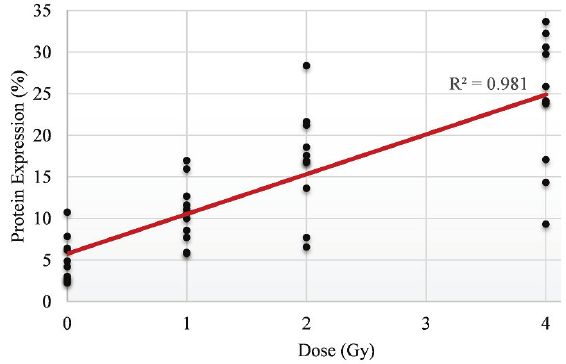
Figure 3 - Dispersion of active caspase-3 expression for lymphocytes incubated for 24 h. Black dots symbolize individual data for each radiation dose (n = 10), and red dots, mean values. The red line represents the linear trendline, displayed with coefficient of determination